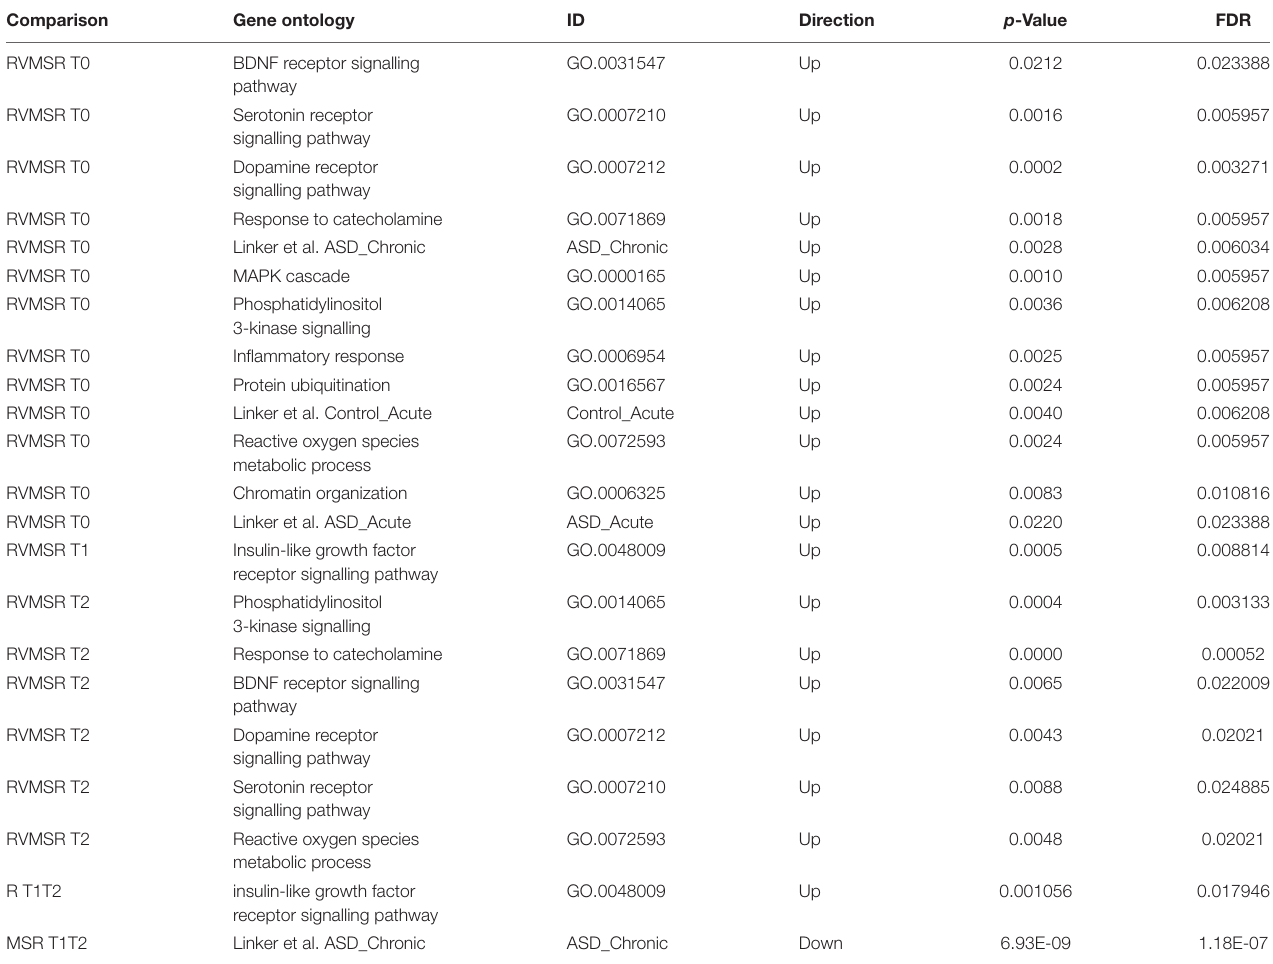
TABLE 7 | Pathways evaluated in hypothesis-driven